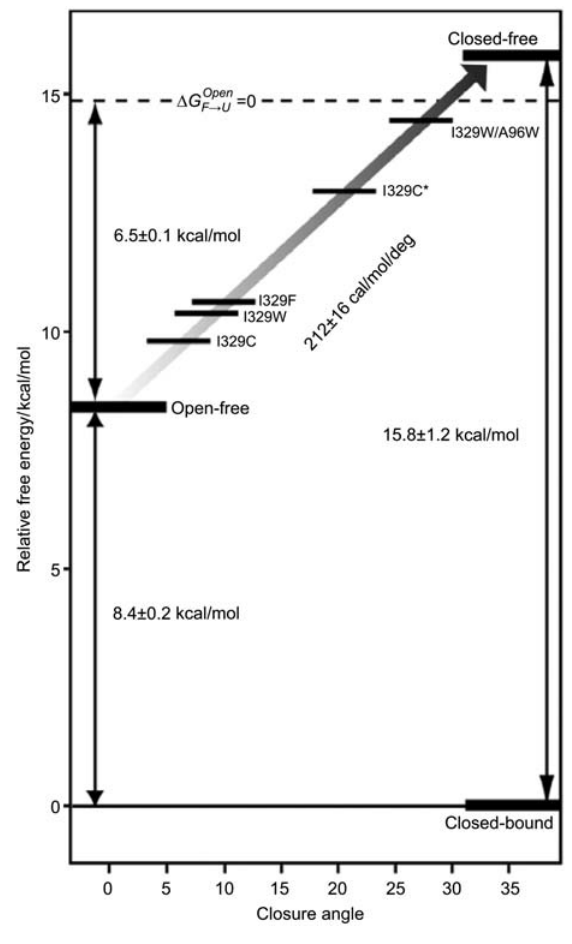
Figure 3 Dependence on interdomain closure angle of the relative free energy of a wild-type MBP polypeptide that adopts either the wild-type conformation or that of hinge mutants I329C, I329W, I329F, I329C*, and I329W/A96W (the asterisk indicates derivati- zation with N -((2-(iodoacetoxy)ethyl)- N -methyl)amino-7-nitrobenz- 2-oxa-1,3-diazole). The closed-liganded state (‘closed-bound’) is arbitrarily set as the energy origin. The energy of a hypothetical closed-unliganded conformation (‘closed-free’) is calculated by extrapolation of the linear correlation extracted from the free-energy change of unfolding ( ) for the unliganded MBP set, which Open D G F ™ U has the wild-type conformation (‘open-free’) as the most stable member. A dashed line indicates the point where unliganded, folded MBP is as stable as the unfolded state. Figure adapted from Ref. (40); Copyright (2003) National Academy of Sciences, USA.